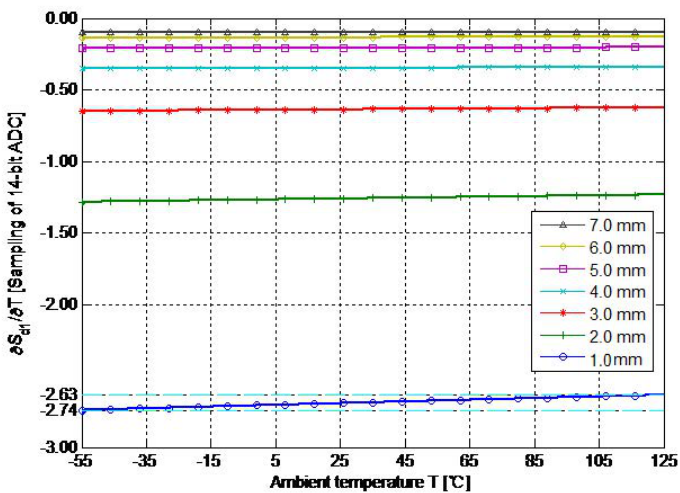
Figure 9. Nonlinear relationship between di ff erential response and ambient